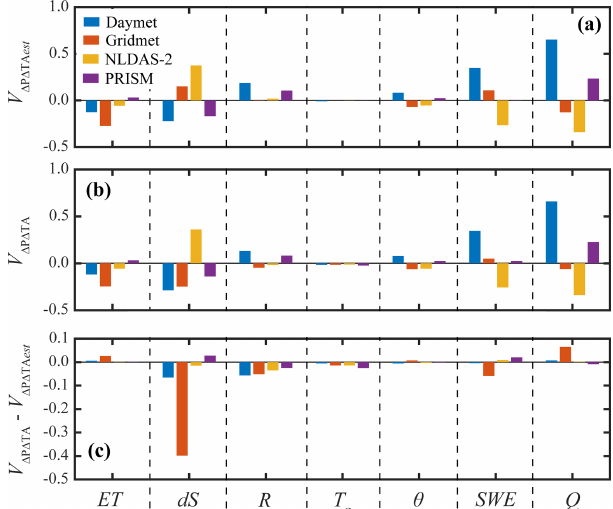
Figure A1. Demonstration of the method to calculate the interaction effects between P and T air uncertainty using WY2016. (a) The es- timated relative difference in the hydrologic variables evapotranspi- ration (ET), change in subsurface storage (d S ), potential recharge ( R ), land surface temperature ( T g ), root zone soil moisture ( θ ), snow water equivalent (SWE), and streamflow ( Q ) if the effects of air temperature and precipitation changes are linearly additive. (b) The relative difference between the base case and each of the VarPVarTA scenarios. (c) The difference between the predicted and actual changes from combined variability in P and T air